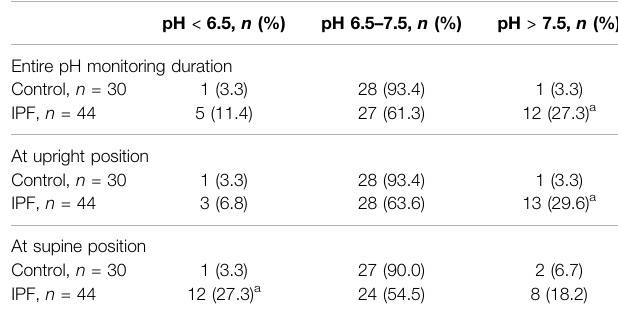
TABLE 4 | Proportions of patients in different pH